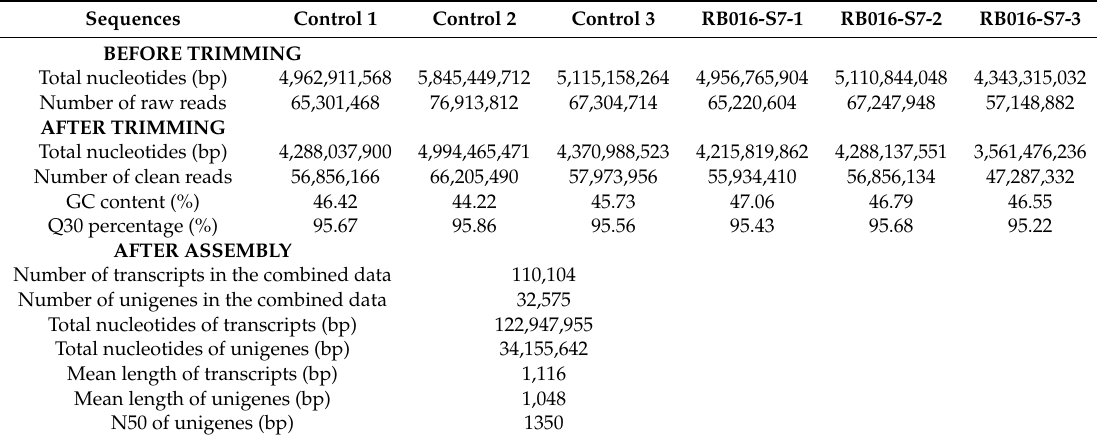
Table 1. Summary of RNA sequencing and de novo transcriptome assembly results.